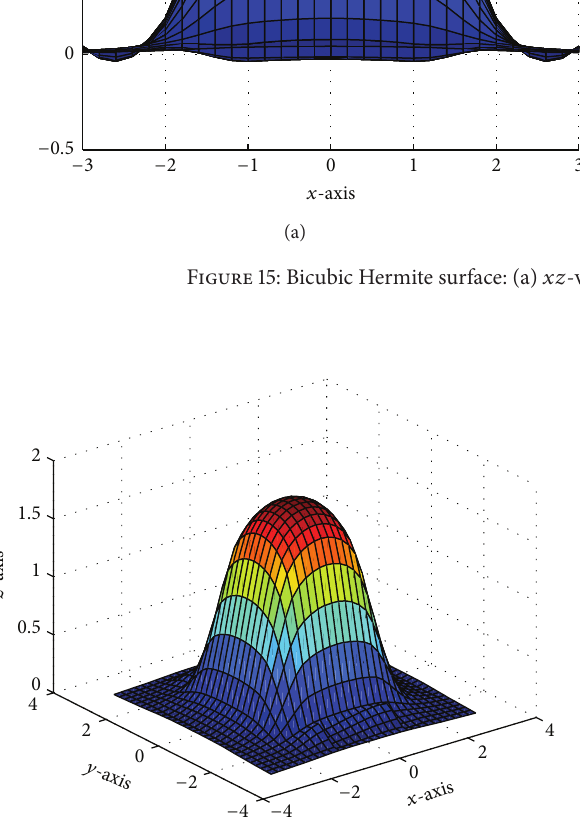
Figure 16: Positivity preserving by using our partially rational bicu- bic spline.